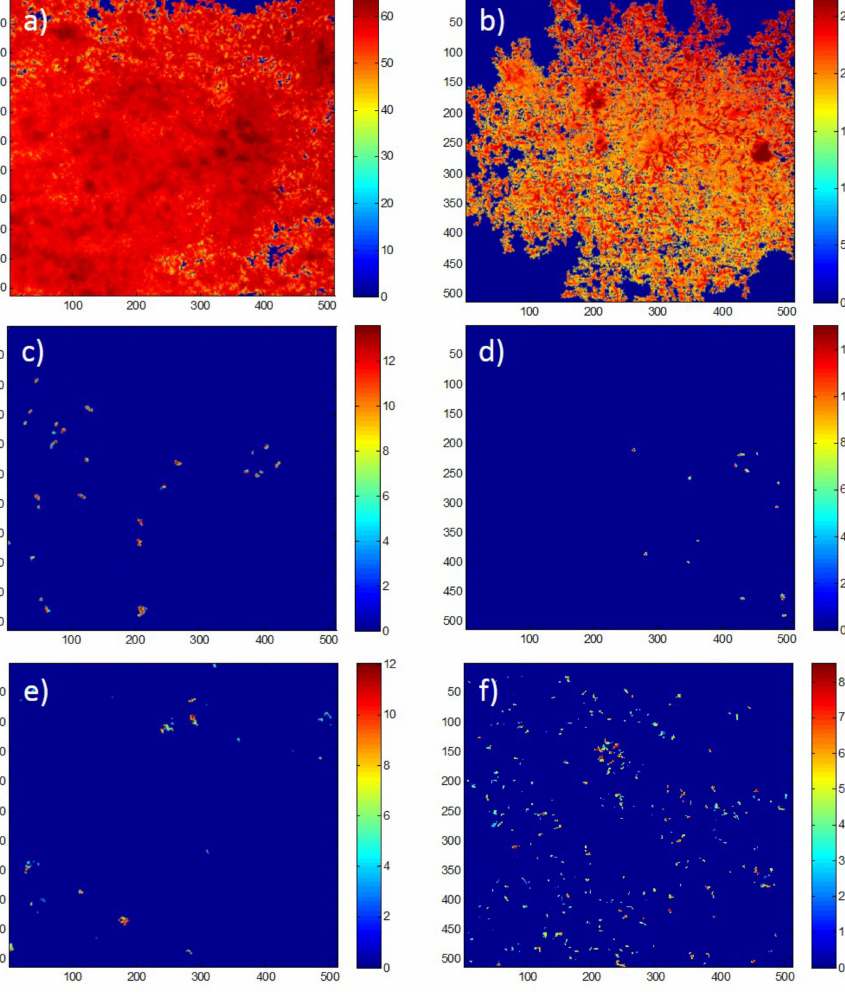
Figure 7. Representative COMSTAT (MATLAB) intensity map reflecting biofilm thickness (scale in µ m) on ( a ) PMMA + ROS, ( b ) PMMA, ( c ) PMMA+ ROS + JUG, ( d ) PMMA + JUG, ( e ) PMMA + ROS + Cu 2 O, f) PMMA + Cu 2 O. JUG = juglone, PMMA = poly(methyl methacrylate), ROS =